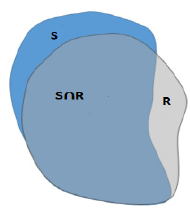
Figure 9. Dice similarity coefficient.